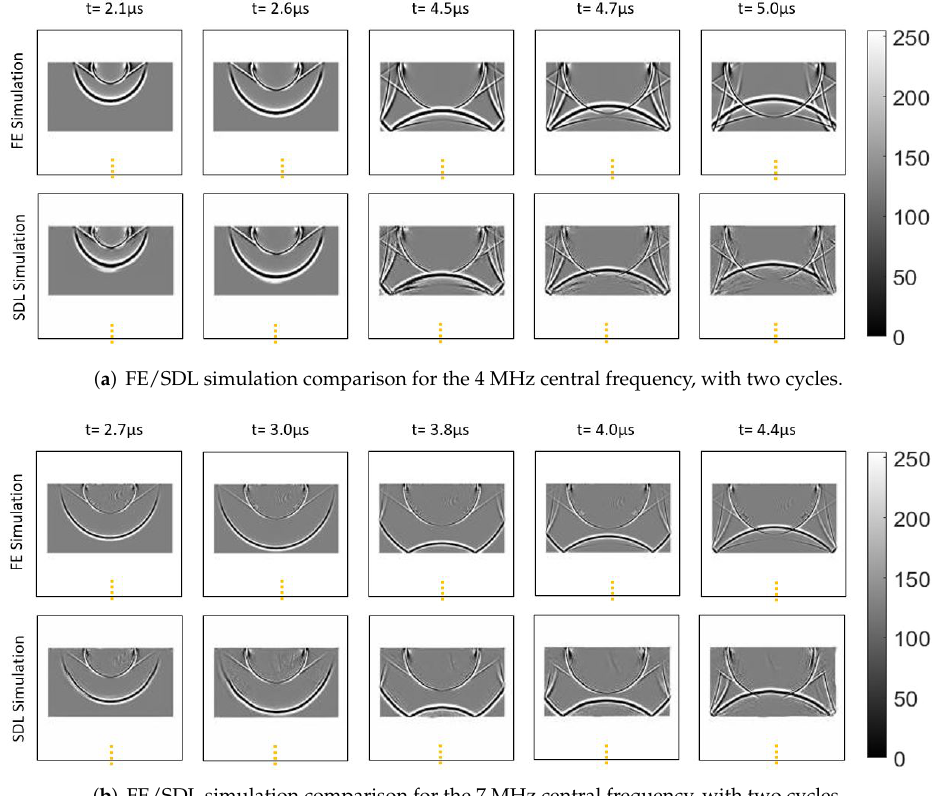
Figure 8. Reflected wave propagation with varying frequency: the SDL model is used for modelling reflected wave propagation in a rectangular domain for varying frequencies and two cycles with a single-point excitation source on the top edge, compared with FE simulation. ( a ) Shows the wave propagation simulation for 4 MHz central frequency, and ( b ) represents the wave propagation simulation for 7 MHz.